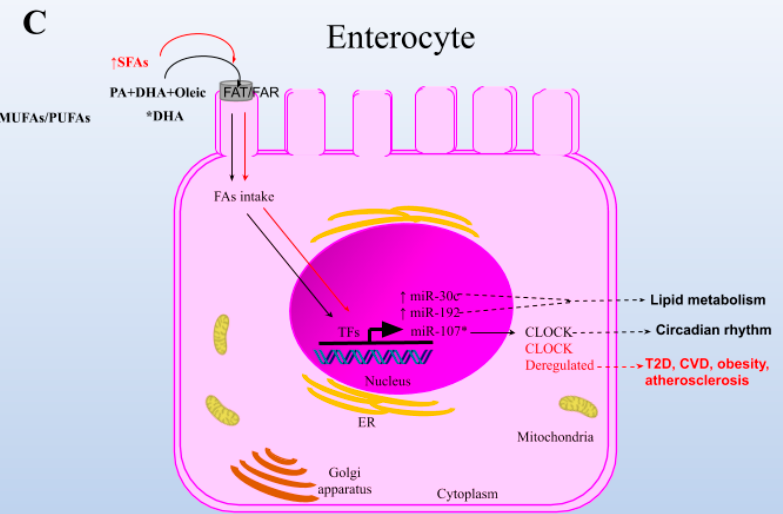
Figure 1. Dietary fatty acids (DFAs) regulate miRNA expression across different cell types. Regulatory mechanisms of miRNAs by (DFAs). Different treatments with monounsaturated fatty acids (MUFAs), as oleic or palmitic acid (PA), or polyunsaturated fatty acids (PUFAs), as docosahexaenoic ac (DHA) or eicosapentaenoic acid (EPA), or conjugated acid linoleic (CLA), used individually or in combination, leads to changes in specific microRNAs (miRNAs), either by inducing ( ↑ ) or repressing ( ↓ ) their expression, targeting genes and modulate them. DFAs get into cells through fatty acid transporters (FAT) or fatty acid receptors (FAR) ( A ) In hepatocytes, PUFAs reduce the expression of genes involved in fatty acid and cholesterol synthesis by binding and inactivating Ubiquitin regulatory X domain-containing protein 8 (UBXD8), thereby inhibiting the proteolytic processing of sterol binding protein (SREBP1). PUFAs also reduce the expression of L-type pyruvate kinase (glycolysis) in the liver, probably by inhibiting the nuclear translocation of MAX-like protein X (MLX)-carbohydrate responsive element binding protein (ChREBP). The activation of peroxisome proliferator activated receptor alpha (PPAR α ) by different PUFAs, or retinoid X receptor (RXR) specifically by DHA, leads to the stimulation of FAs catabolism [46]. Conversely, the SFAs induce miRNA changes which in turn, modulate the expression of target genes involved in the development of liver steatosis, insulin resistance, non-alcoholic fatty liver disease (NAFLD) and obesity. In adipocytes, EPA treatment it has shown modulated microRNAs associated with the improvement of dyslipidemia, whereas CLA treatment has shown to regulate the miRNAs expression, whose target genes are involved in lipid metabolism. ( B ) In pancreatic β cells, during a pre-diabetic state, high fat diet intake results in the deregulation of miRNAs related with function and survival of these cells. The effect of PUFAS/MUFAS has not been described in pancreatic cells. In Macrophages, Toll-like receptor 4 (TLR4) is present, and it has been proposed to be activated by saturated fatty acids (SFAs) [48]. In this cells, high fat diet intake results in changes of miRNAs expression related with insulin resistance, inflammation and cancer. DHA treatment have shown to modulate the expression of specific miRNAs and their target genes related with lipid metabolism. ( C ) In enterocytes, treatment with DHA or DHA+PA+oleic modulate the expression of miRNAs involved in lipid metabolism, while cellular intake of SFAs induces deregulation of miRNAs and their genes involved in the development of diseases such as Type 2 Diabetes (T2D), cardiovascular diseases (CVD), obesity and atherosclerosis. TFs was used to designate possible transcription factors not described or specified. Asterisks (*, **, or ***) were used to indicate the different treatments and their corresponding regulated miRNAs.